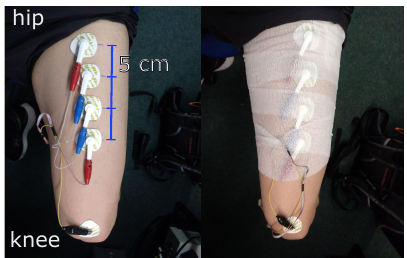
Figure 9. Placement of the electrodes on the upper leg. The ECG electrodes are placed with a distance of 5 cm from center to center ( left ). The electrodes are fixed with a bandage ( right